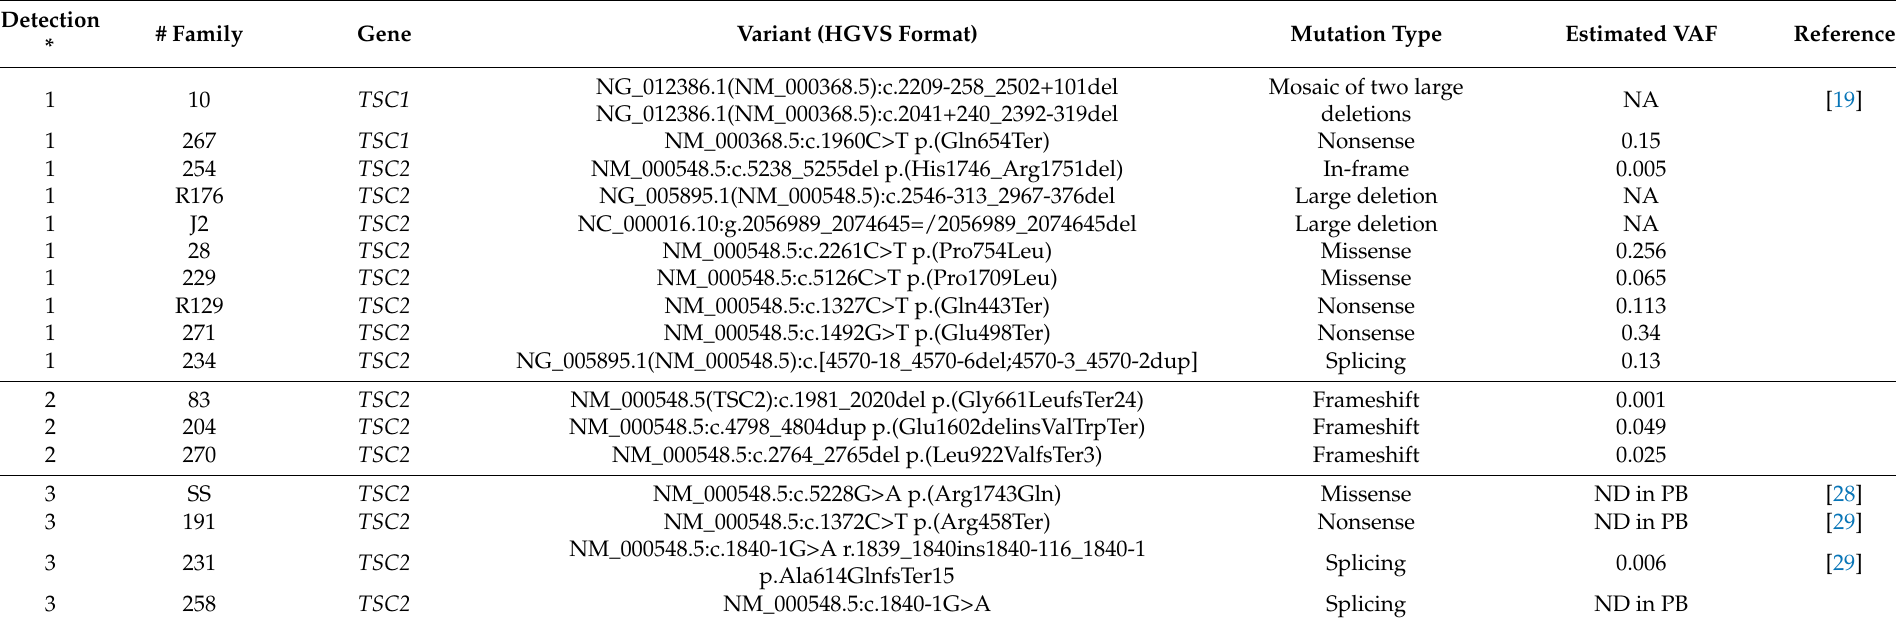
Table 9. Mosaic mutations detected in the patients with